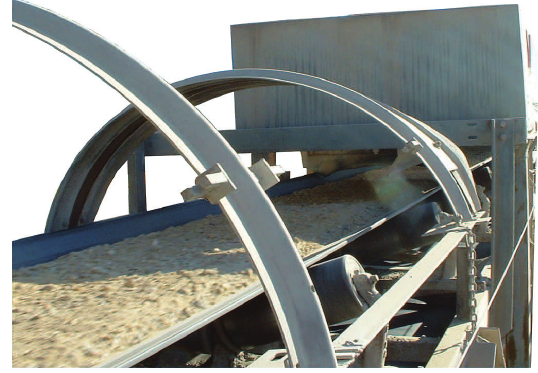
Fig. 7 Sampling from falling conveyors: ( a ) bad sampling technique, ( b ) good sampling technique, ( c ) sampling procedure to be adopted for high mass flow rate. (Cour- tesy of Reg Davies, 2009)